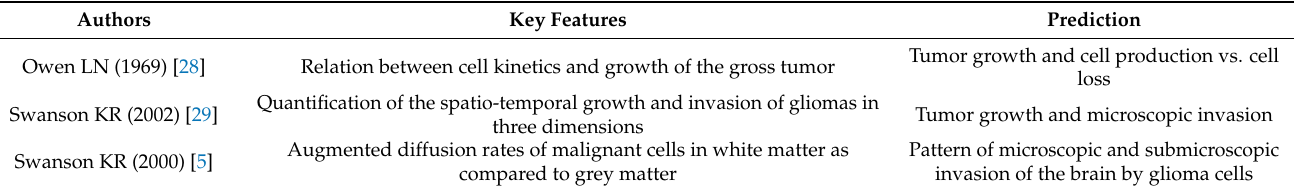
Table 1. Principal innovation in the continuum mathematical models of